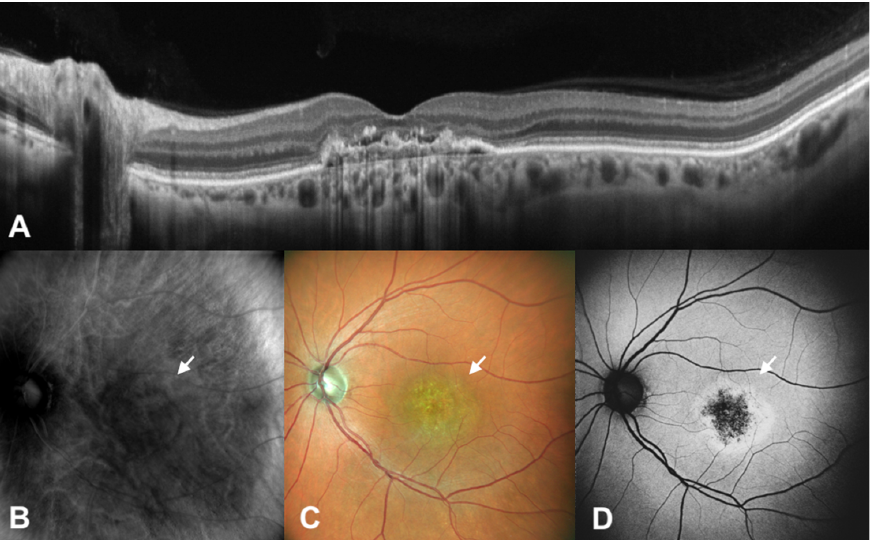
Figure 4. Patient with central serous chorioretinopathy assesed by multimodal imaging (IV). In Figure 4, we see a patient with central serous chorioretinopathy assesed by spectral domain optical coherence tomography (SD-OCT) ( A ), scanning laser ophthalmoscopy (SLO) retromode imaging ( B ), SLO color fundus imaging ( C ) and fundus autofluorescence (FAF) ( D ). In this case, we have the presence of a central RPE scar with outer retinal degeneration (arrows, highlighting atrophy at fundus images). SLO retromode imaging has difficulty in highlighting the area of RPE dystrophy, while FAF provides information on central RPE atrophy and surrounding outer retinal